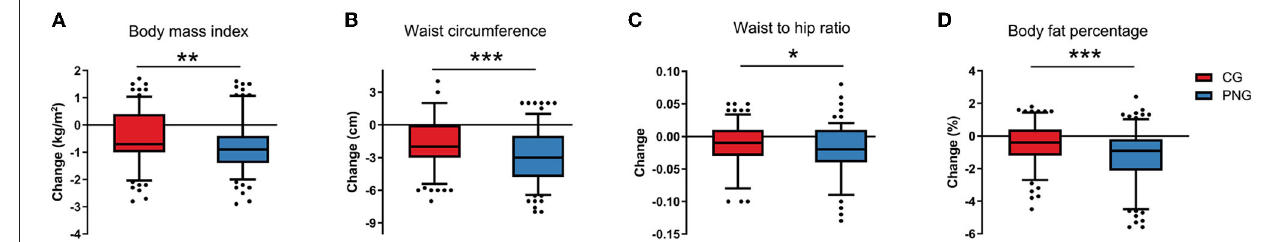
FIGURE 3 | Changes in anthropometric measurements between CG and PNG. Intergroup differences in changes in anthropometric measurements (A–D) were evaluated using Wilcoxon–Mann–Whitney test. * P < 0.05, ** P < 0.01, *** P <